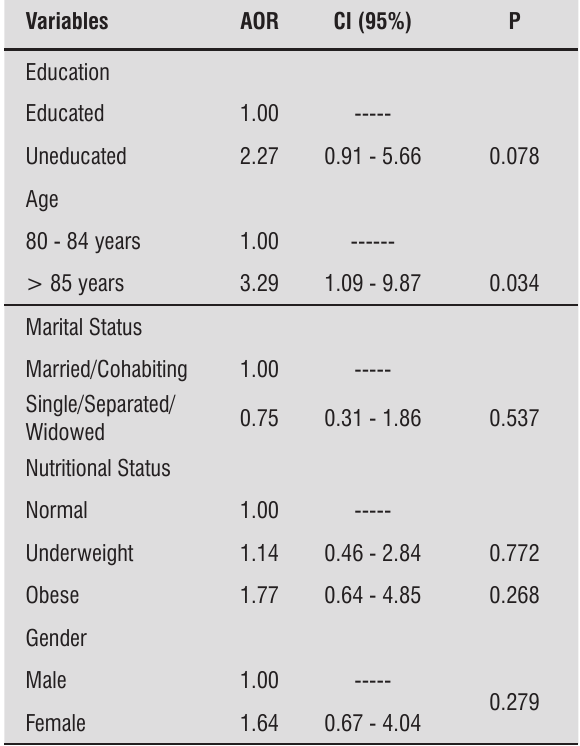
Table 3 - Multiple logistic regression model with sociode- mographic factors related to mobility limitation in Table 2 - Odds ratio for limited mobility according to so-